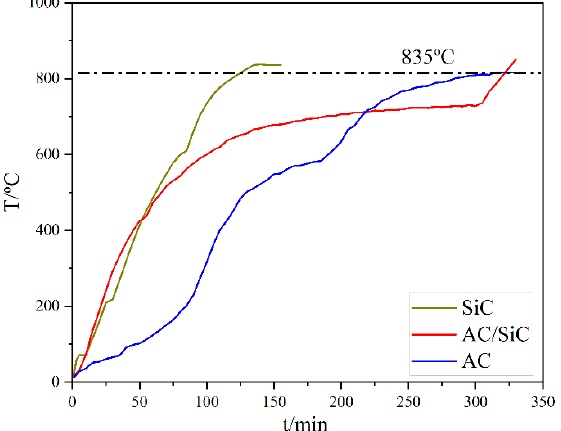
Figure 4. Temperature rise curve of the different microwave susceptors.